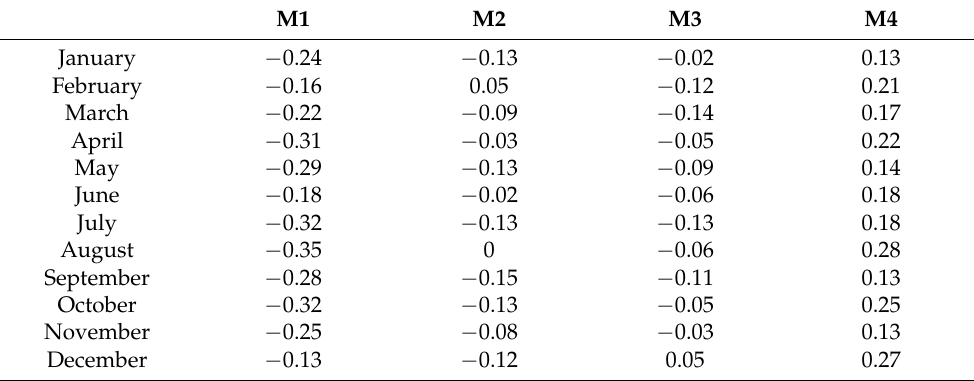
Table 4. Values of the Spearman rho correlation coefficient between the values of electricity consump- tion and horizontal insolation in individual months in 4 analyzed cases of